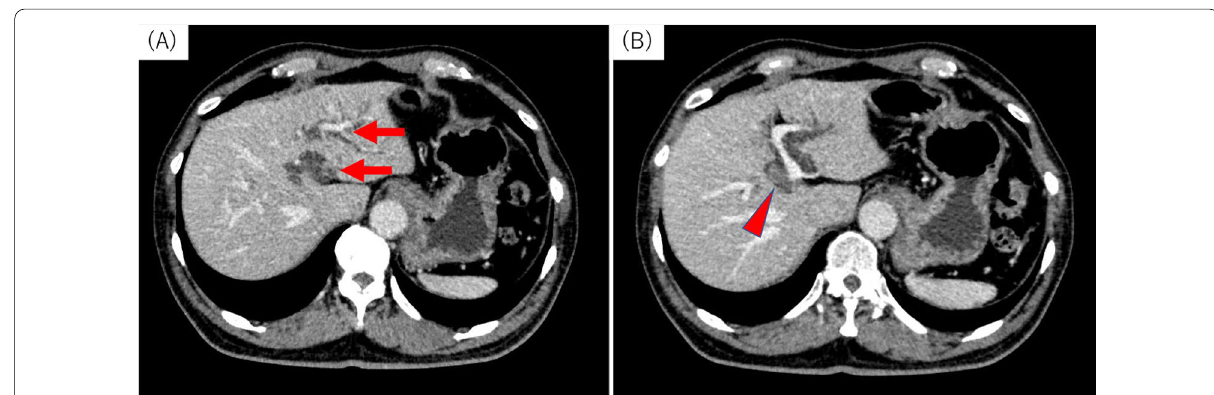
Fig. 1 Contrast-enhanced computed tomography findings for the primary lesion. A Dilation of the intrahepatic bile duct was noted (arrow). B A mass of approximately 10 mm in diameter with sight enhancement was noted in the left hepatic duct (red arrowhead)